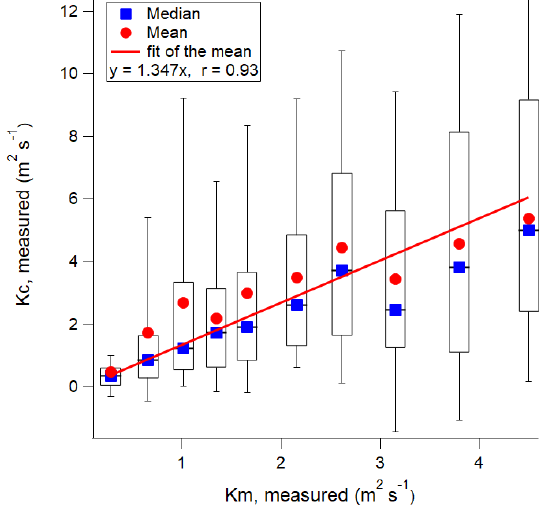
Figure 2. Calculating the Schmidt number Sc as a constant over the entire study. Lower and upper bounds of the box are the 25th and 75th percentile of each bin; the lines in the box and the blue squares mark the median; the red circle labels the mean of the data in each bin; whiskers are the 10th and 90th percentile of the data. In this analysis, measured K c values were binned by K m with 65points in each bin. Bin centers were the median K m measured of each bin. The red line is the best fit of mean K c vs. median K m of each bin. The p value of the fit = 0.0001. Points with K m > 5m 2 s − 1 were excluded in the fit.